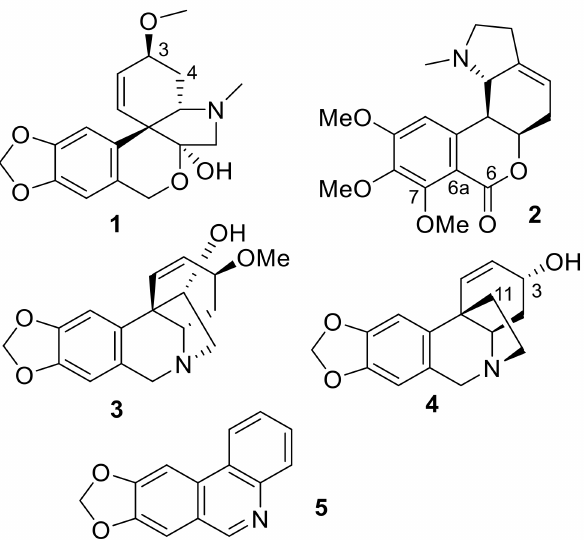
Figure 4. Structure of tazettine 1 , albomaculine 2 , haemanthamine 3 , crinine 4 , and trisphaeridine 5